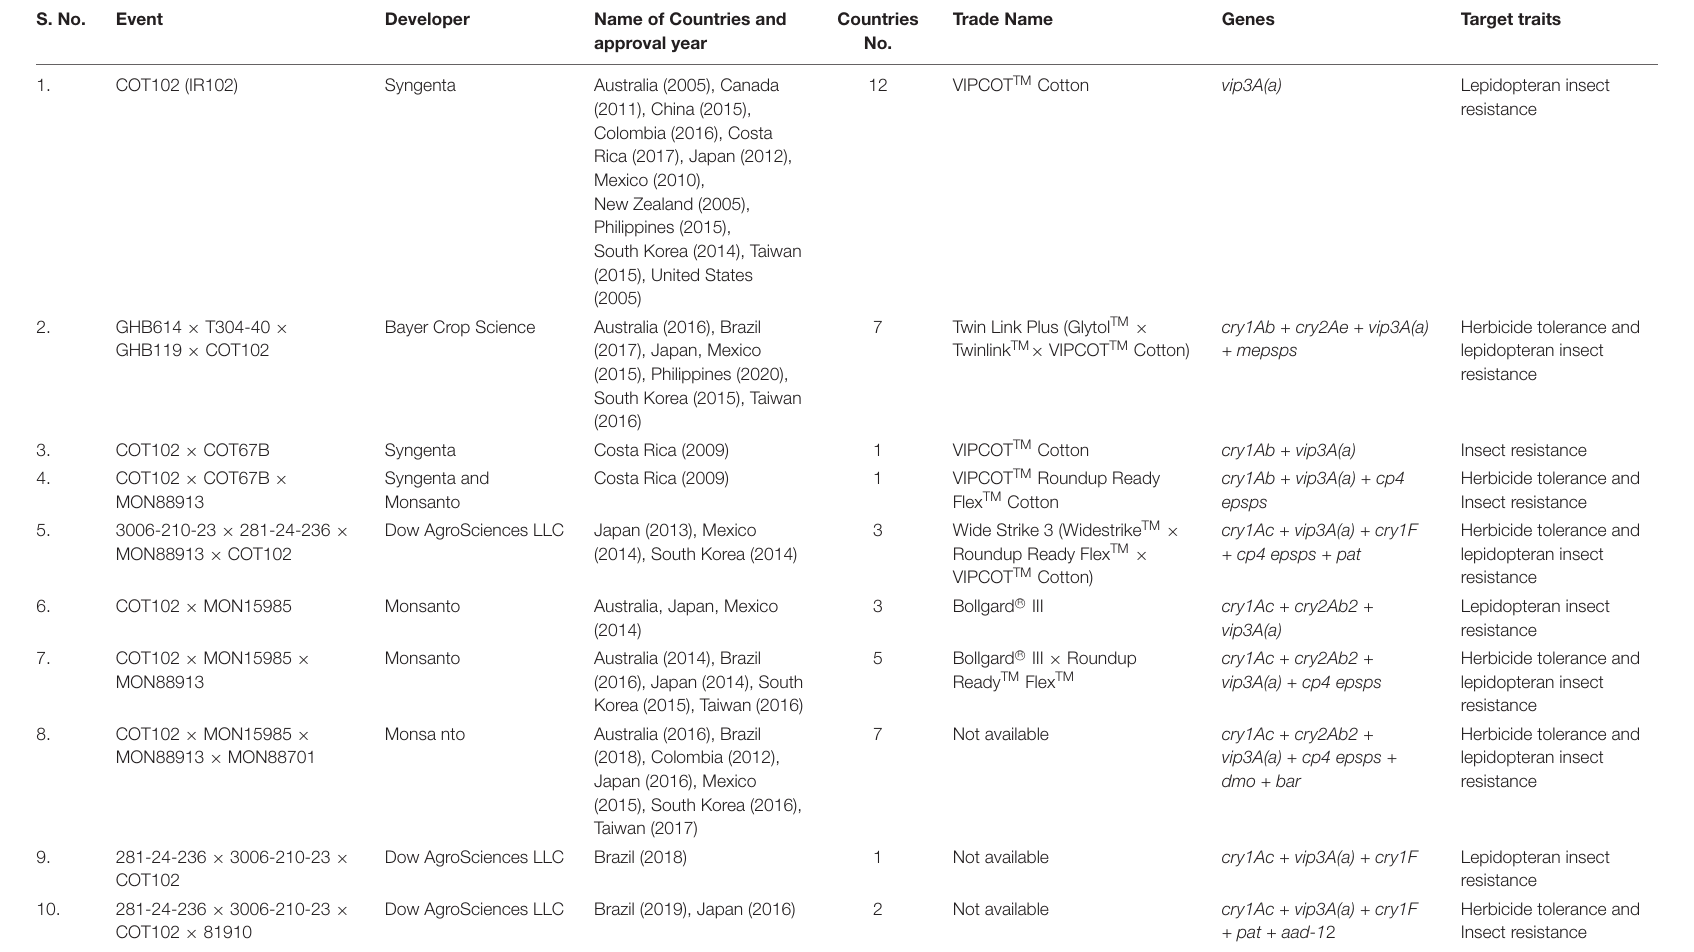
TABLE 5 | List of approved events containing Vip3A proteins in commercial Bt cotton in different countries. S.